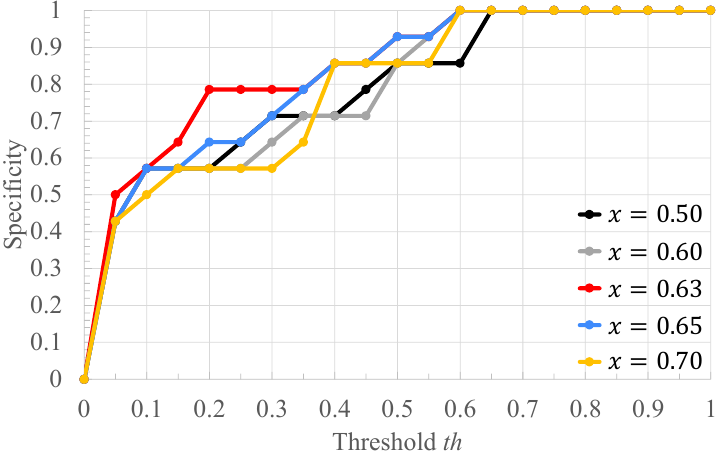
Figure 7. The specificity of the proposed method when the threshold x used for RRI classification is